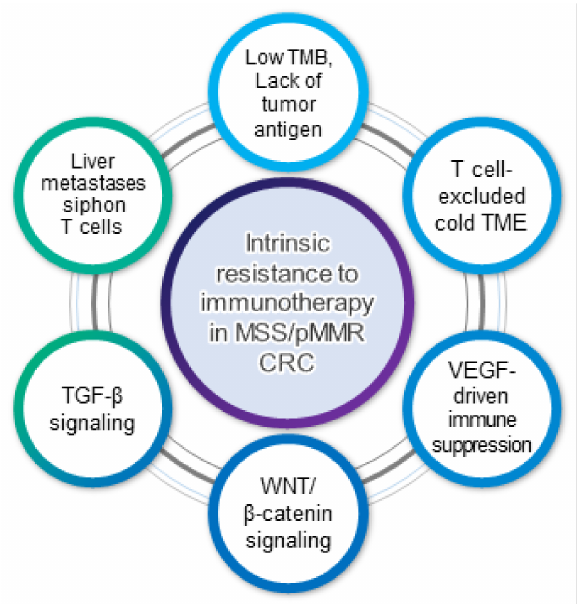
Figure 1. Mechanisms of resistance to immunotherapy in MSS/pMMR